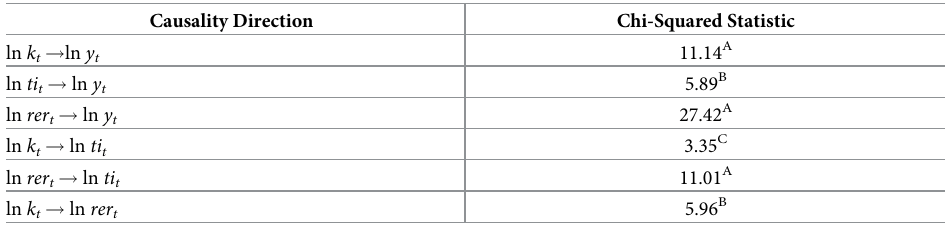
Table 11. Causality